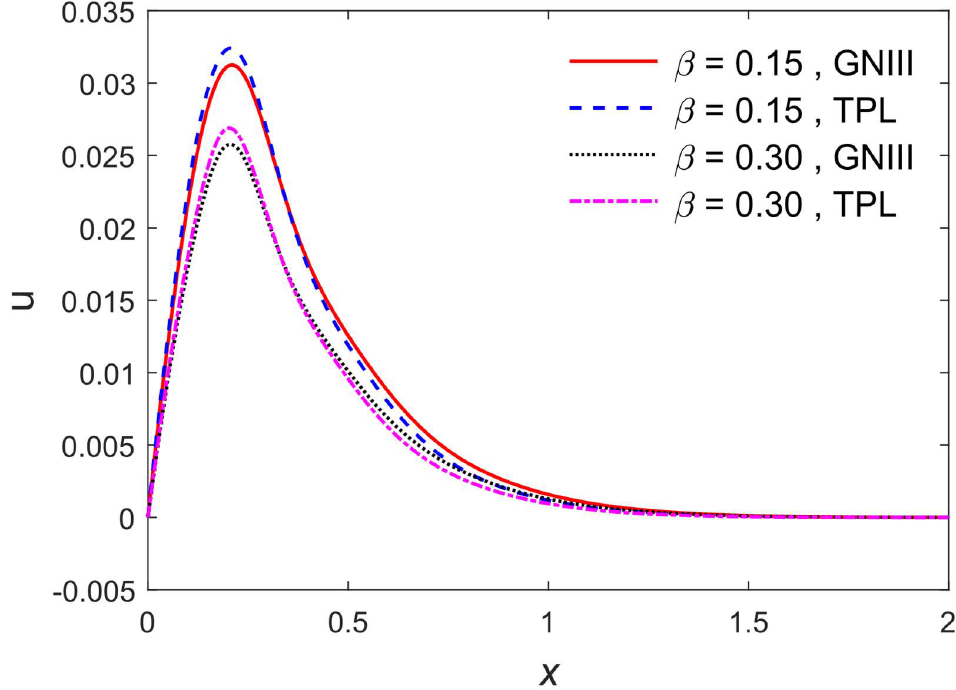
Figure 2. The distributions of solid displacement u along the distance x